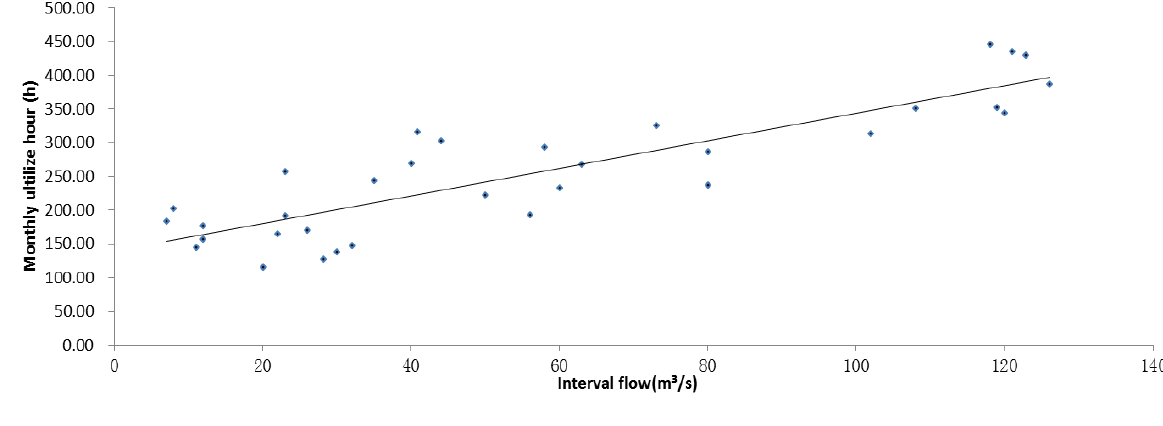
Figure 7. Linear curve fitting of LHP and SHP in Puer